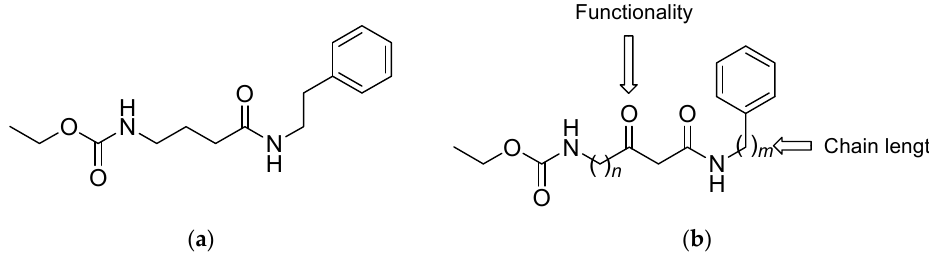
Figure 1. Santacruzamate A ( a ) and oxygenated analogues ( b ).